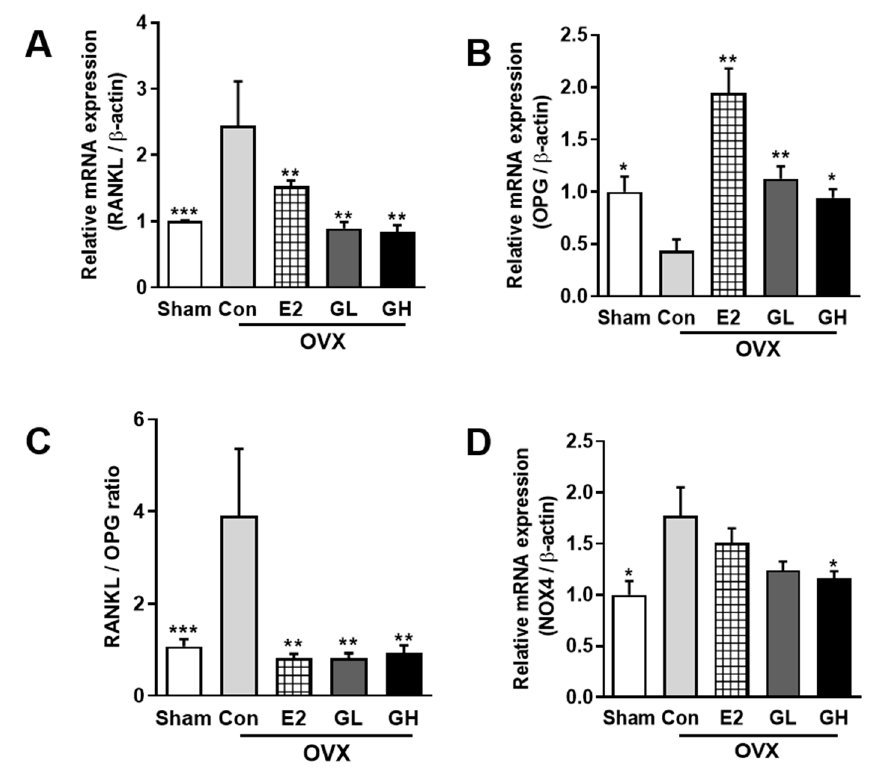
Figure 6. Effect of GTE supplementation on osteoclast activities. The relative mRNA expression of RANKL ( A ) and OPG ( B ) measured using quantitative RT-PCR in tibia bones of all groups. ( C ) Calculation of RANK/OPG ratio. ( D ) Relative mRNA expression of Nox-4. *** p < 0.001, ** p < 0.01, * p < 0.05, significantly different from Con.